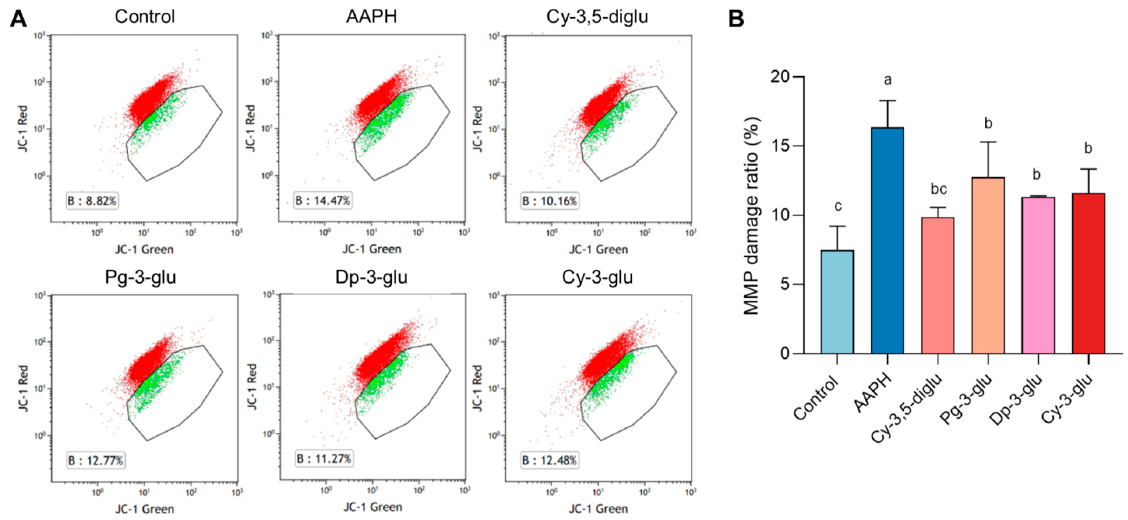
Figure 5. Anthocyanins reduce mitochondrial membrane potential damage : ( A ) Representative flow cytometry diagram of changes in MMP after treatment with four anthocyanins. ( B ) The ratio analysis of MMP damage cells, n = 3. All data were analyzed for differences by one-way ANOVA. Different letters indicated that there is a significant difference ( p < 0.05).